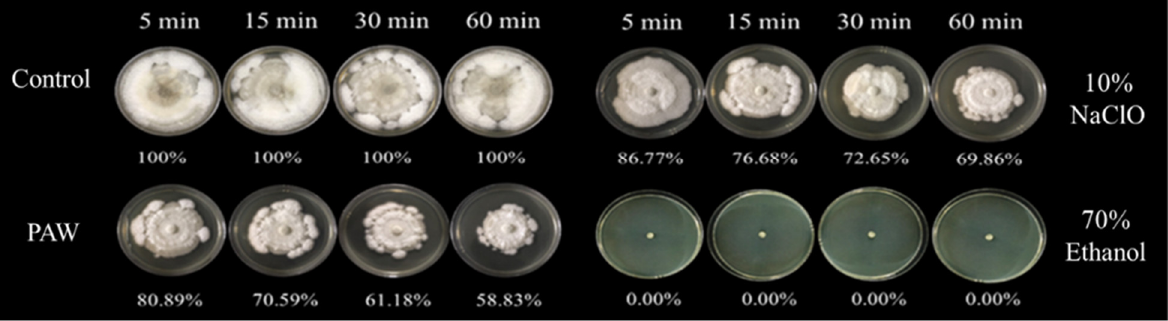
Figure 9. Mycelial growth of C. gloeosporioides after being treated with DI water, PAW, 10% NaClO, and 70% ethanol.